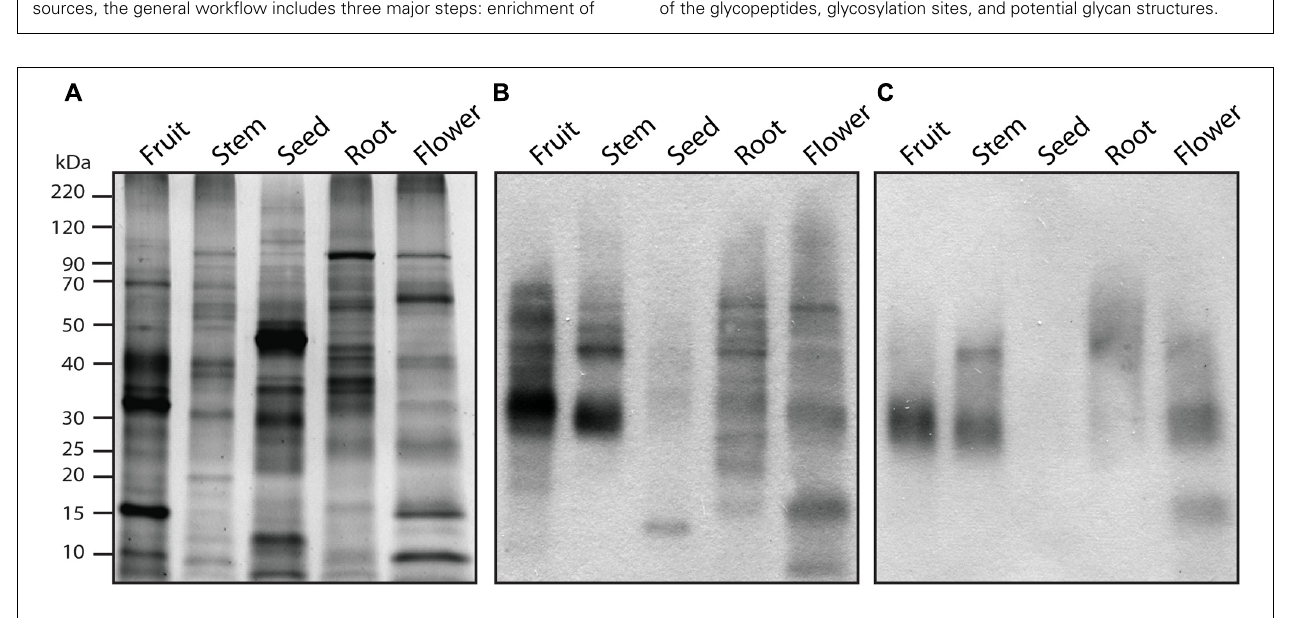
FIGURE 1 |A schematic overview of experimental approaches for the systematic characterization of glycoproteins by mass spectrometry-based proteomic analysis. Regardless of the sample sources, the general workflow includes three major steps: enrichment of